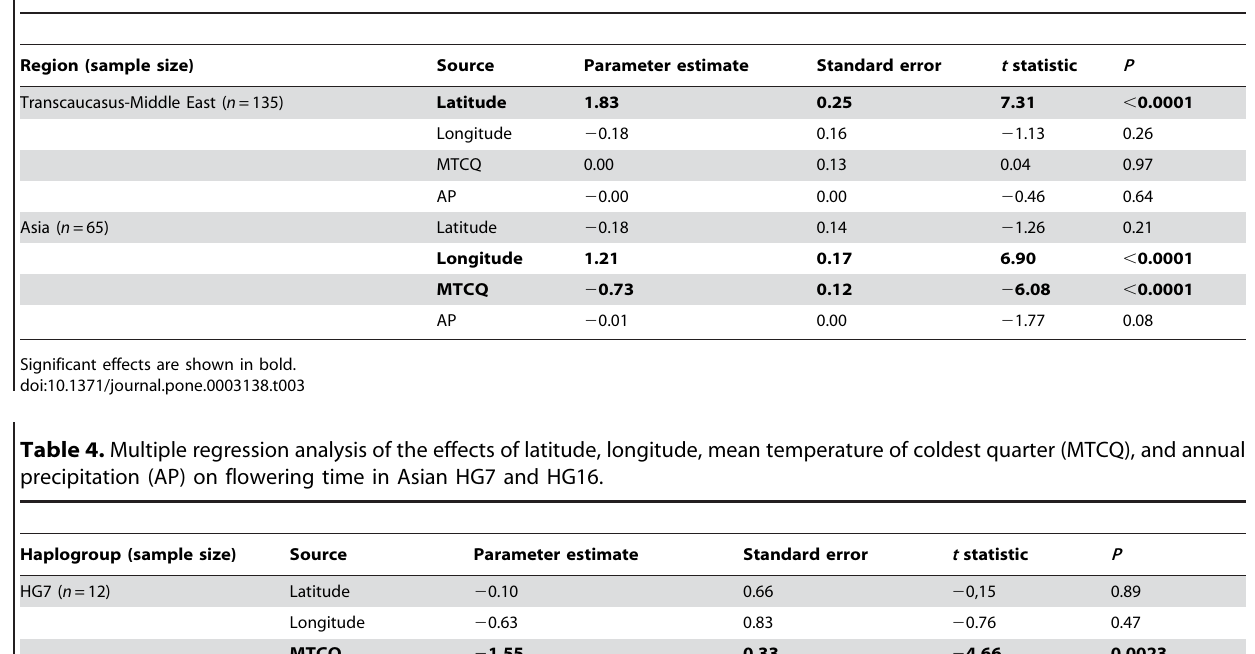
Table 3. Multiple regression analysis of the effects of latitude, longitude, mean temperature of coldest quarter (MTCQ), and annual precipitation (AP) on flowering time in Transcaucasus-Middle East and Asia.